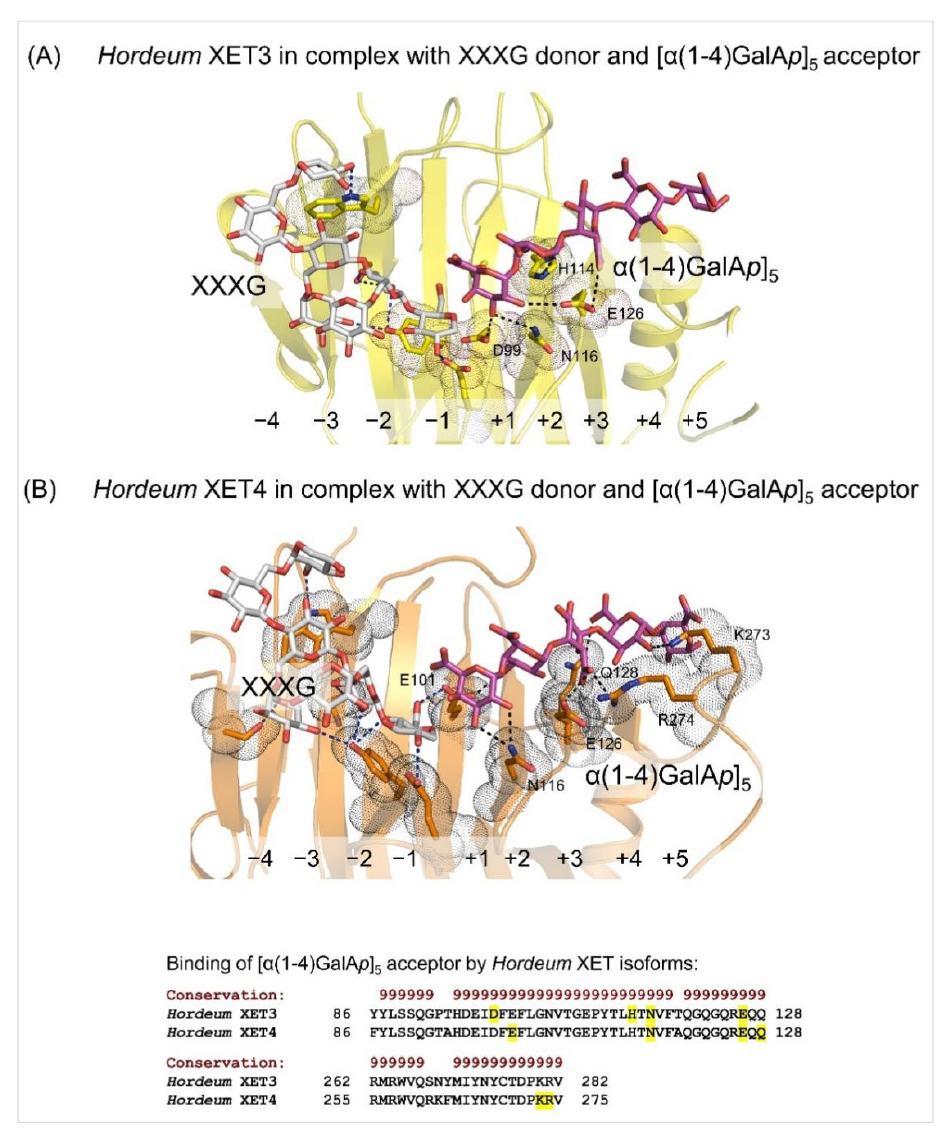
Figure 4. Details of the XXXG donor (cpk sticks) and the [ α (1-4)GalA p ] 5 acceptor (magenta cpk sticks) binding substrates in Hordeum XET3 ( A ) and Hordeum XET4 ( B ). In both panels, blue and black dashed lines indicate residue separations between donors or acceptors that are 2.6 Å–3.6 Å (XET3) and 2.7 Å–3.4 Å (XET4). Interacting residues are shown in yellow (XET3) and orange (XET4) cpk sticks and emphasised in dots. Subsites at -4 to -1 for XXXG and +1 to +5 for [ α (1-4)GalA p ] 5 are indicated. Images were generated in PyMOL as referenced in Figure 2. Bottom panel : Some of the residues of Hordeum XETs that bind [ α (1-4)GalA p ] 5 (highlighted in yellow) are shown in the alignment by PROMALS3D [83] of the Hordeum XET sequences (numbering includes signal peptides). Conservation of residues on the scale 9–6 is shown on the top of the alignment in